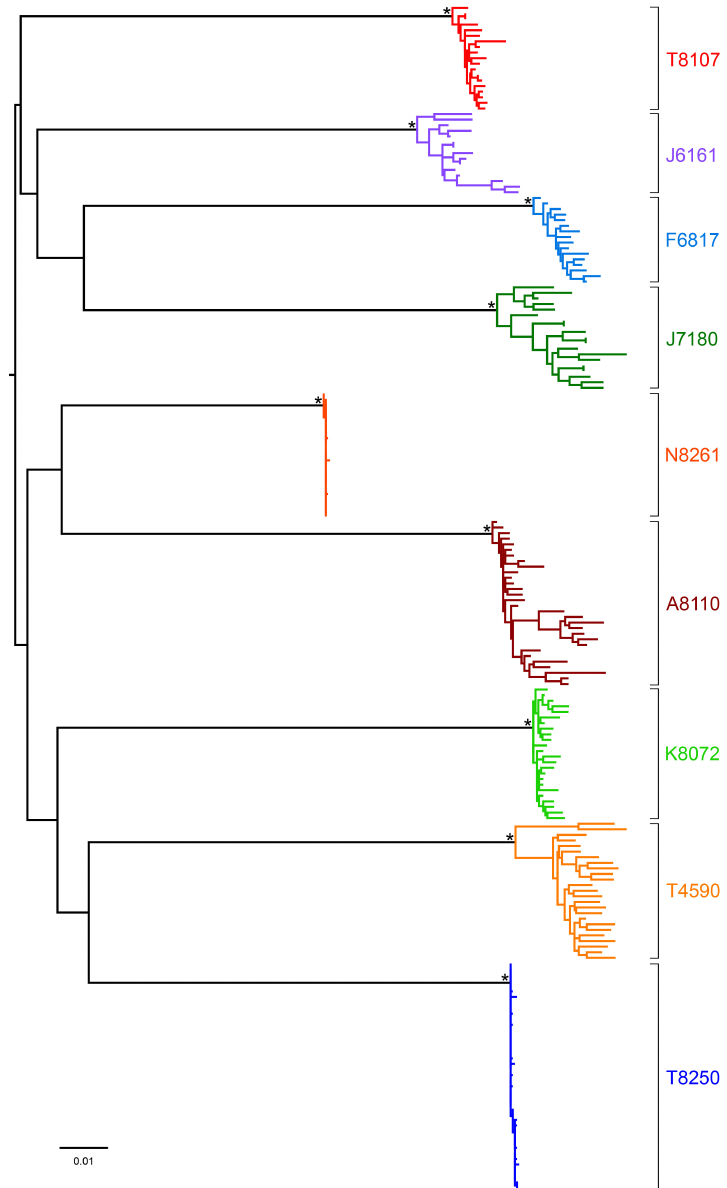
Supplementary Figure 1. Maximum-likelihood phylogenetic tree of all study participants. The 9 study subjects’ SGA-derived gp160 env sequences cluster independently, demonstrating a lack of cross-contami- nation. Sequences are color-coded by subject. Genetic distance is indicated by the scale